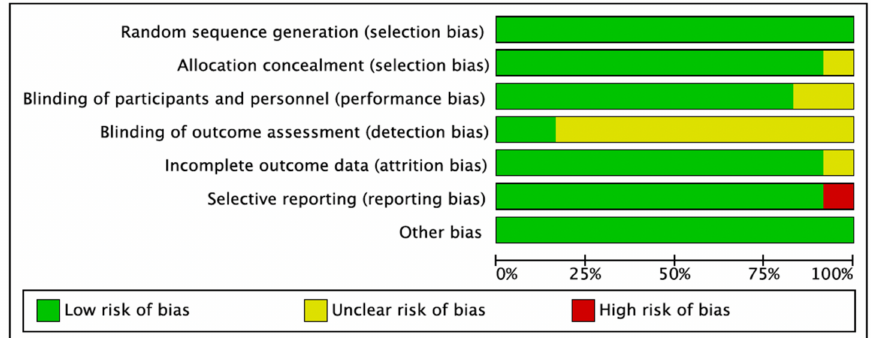
Figure 7. Risk of bias graph: review of authors’ judgments on each risk of bias item presented as percentages across all included studies. Green denotes features at a low risk of bias, red denotes a feature at a high risk of bias, and yellow denotes features at an unclear risk of bias.